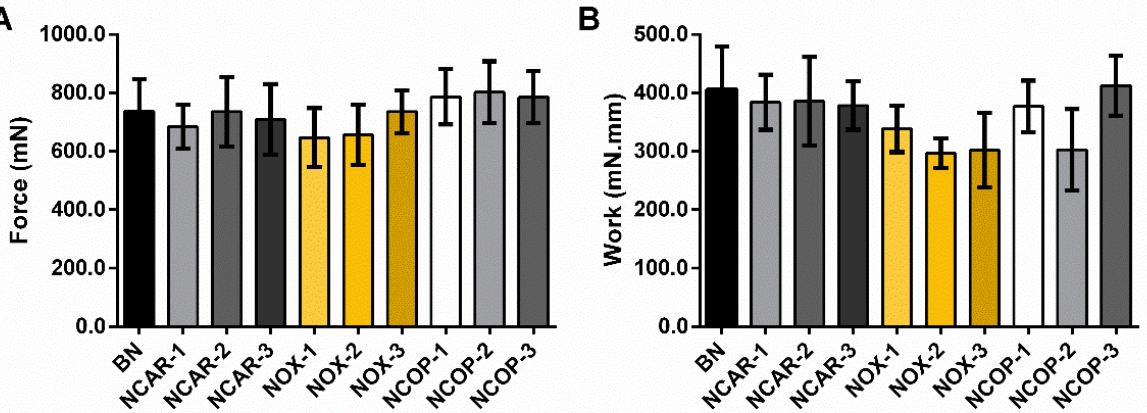
Figure 2. Bioadhesive parameters of nanoemulgels of β -caryophyllene (NCARs), nanoemulgels of caryophyllene oxide (NOXs), and nanoemulgels of C. multijuga oleoresin (NCOPs). Force (mN) ( A ); Work of adhesion (mN.mm) ( B ). The nanoemulgels (n = 6/group) were put in contact with the skin by a force of 2.5 N for 180 s. After, the probe was lifted at a constant rate of 1.0 mm/s. Data are reported as mean ± SD and were statistically evaluated using one-way ANOVA followed by Tukey’s post hoc test ( p > 0.05).